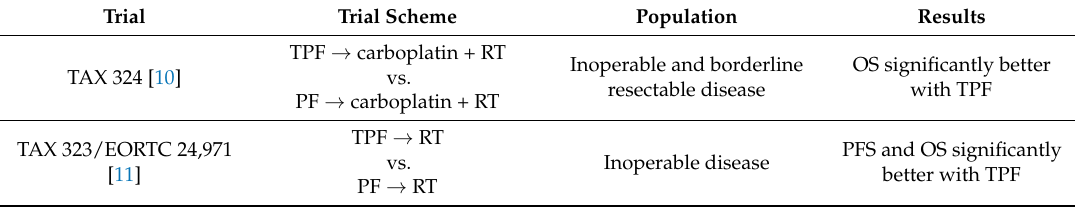
Table 1. The two trials that made TPF (docetaxel, cisplatin, and fluorouracil) the standard of care. T: radiotherapy; PFS: progression-free survival; OS. overall survival. PF: cisplatin, and fluorouracil